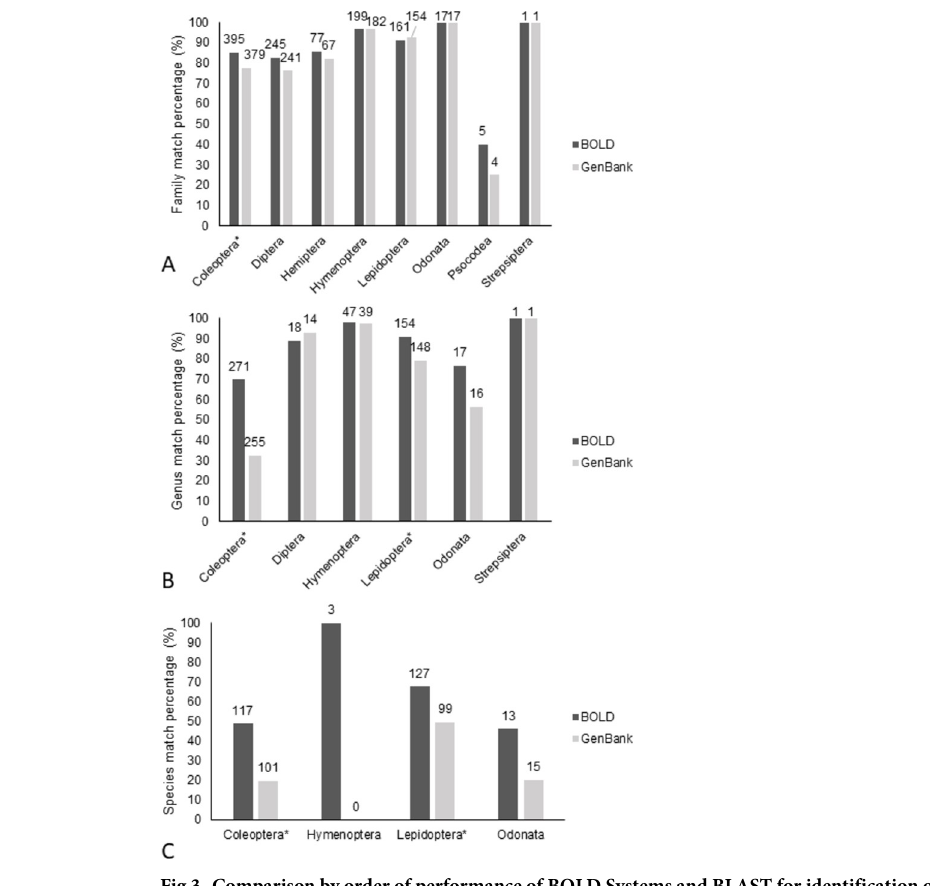
Fig 3. Comparison by order of performance of BOLD Systems and BLAST for identification of specimens in percentages. Correct matches for BOLD Batch ID engine at 80% are shown in dark gray. Correct matches from MegaBlast search by default (GenBank) are shown in light gray. * Is next to orders where Chi-square analyzed with Bonferroni correction was significant. The sample size is displayed on top of each column. A) by families. B) by genera C) by